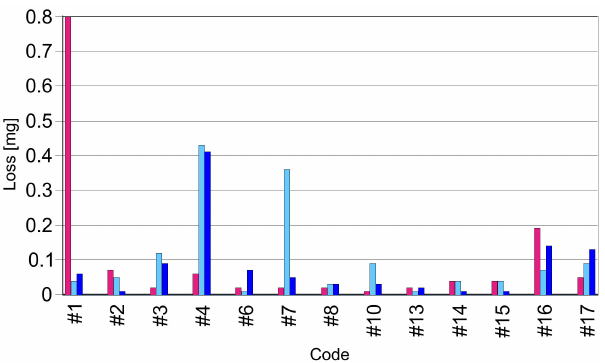
Figure 15. Mass loss of the samples